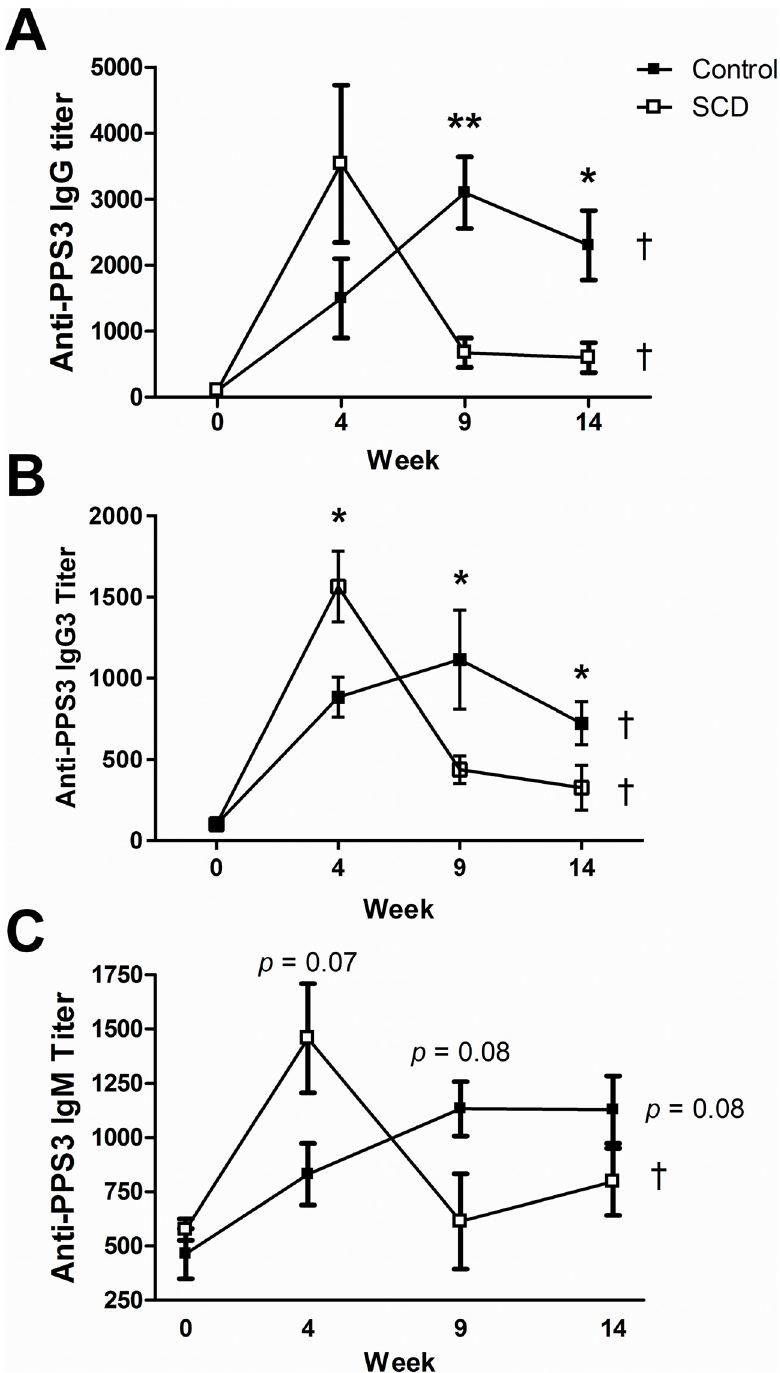
Fig 4. Pneumococcal-specific antibody titers after vaccination. PPS3-specific total IgG (A), IgG3 (B), and IgM (C) antibody titers were measured by ELISA in Prevnar-13 vaccinated 2 – 3 month old control and SCD mice at weeks 0 (before vaccination), 4, 9, and 14. * = p < 0.05 and ** = p < 0.01 for between groups comparisons at the same time point (as determined using a two-tailed Student ’ s T-test) and † = p < 0.05 for within group comparisons across time points (as determined using a One-way ANOVA). For IgM comparisons between groups, p = 0.07 and p = 0.08 at weeks 4 and 9, respectively. For IgM comparisons within the control group, p = 0.08. White boxes = SCD, black boxes =